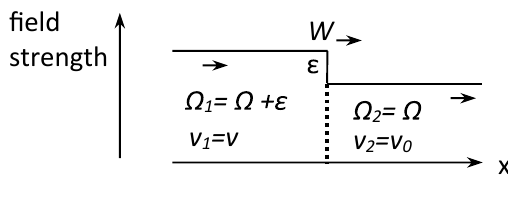
Fig. 4. A perturbation propagating in a moving